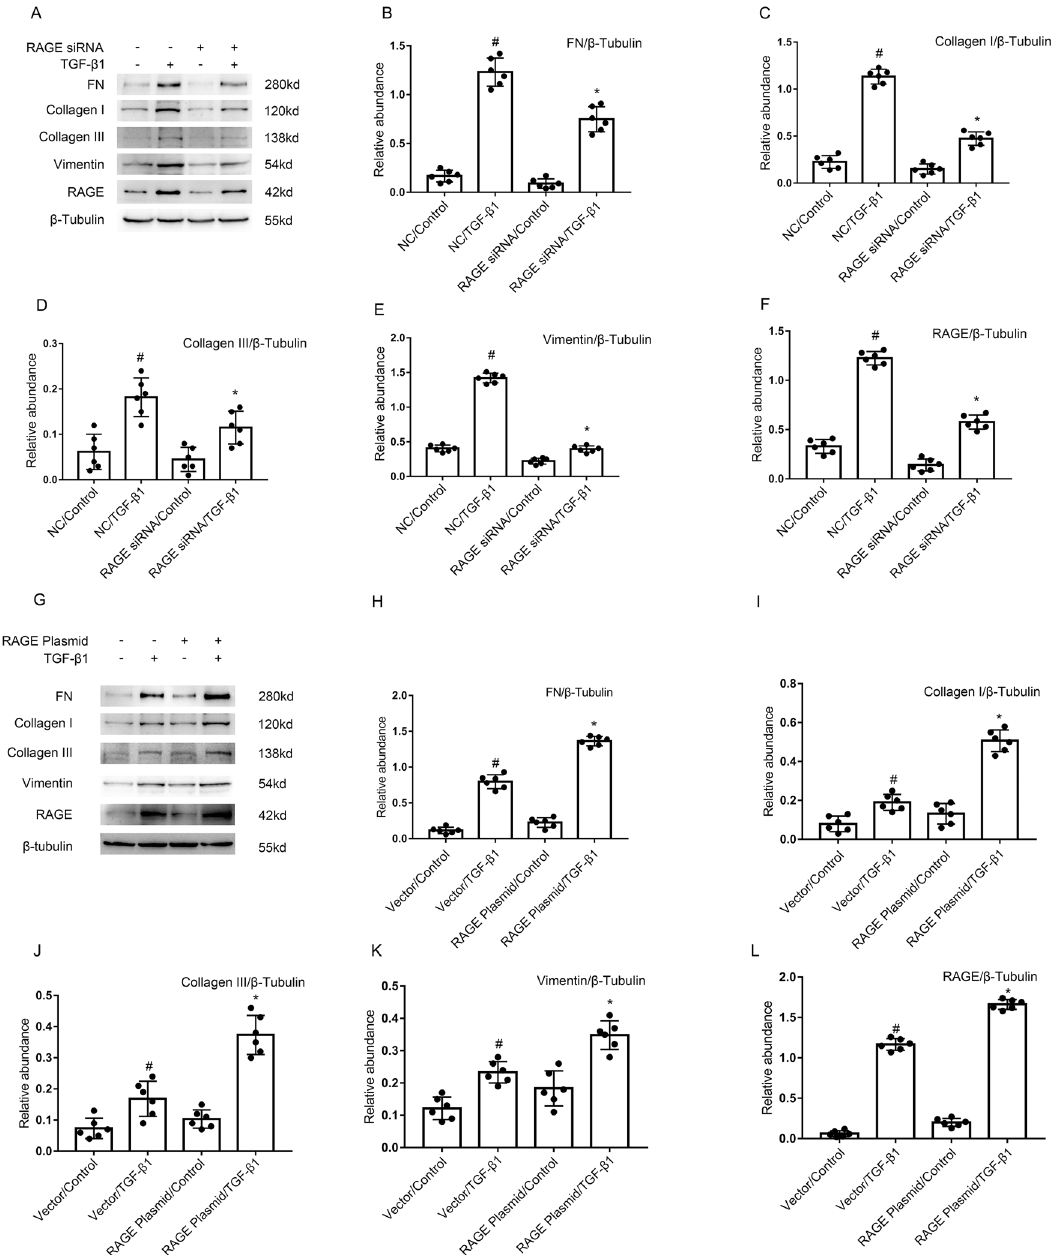
Fig. 2 RAGE mediated the TGF- β 1-induced expression of fi bronectin & Col I&III & vimentin and RAGE in BUMPT cells. The plasmid and siRNA of RAGE were transfected into BUMPT cells and treated with or without 5 ng/ml TGF- β 1 for 24 h. A , G Immunoblot analysis of fi bronectin times independently with similar results. B – F , H – L indicate the statistical Student ’ s t test used (means ± s.d., n = 6, P < employed for comparing multiple groups. Level of statistical signi fi cance was set at P < 0.05. RESULTS Expression of RAGE is upregulated by TGF- β 1 in BUMPT cells, UUO in mice, and in the renal cortices of Ob-patients At the outset, the expression of RAGE in obstructive nephropathy (Ob) patients was upregulated signi fi cantly compared to the control group (Fig. 1C, F). Next, this founding was also con fi rmed in BUMPTs treated with/without TGF- β 1 (Fig. 1A, D), which was the